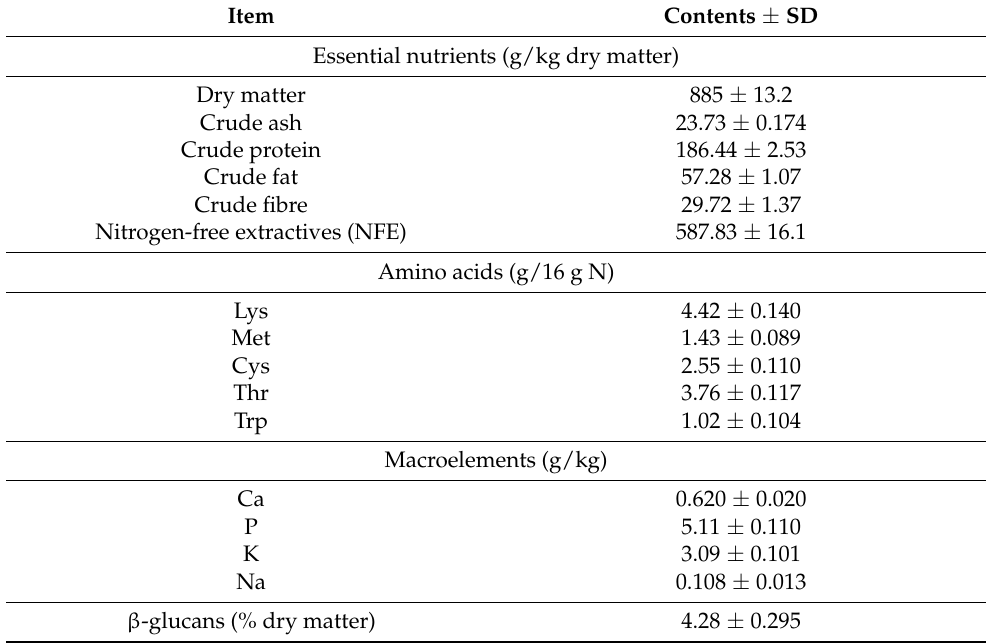
Table 2. Chemical composition of naked